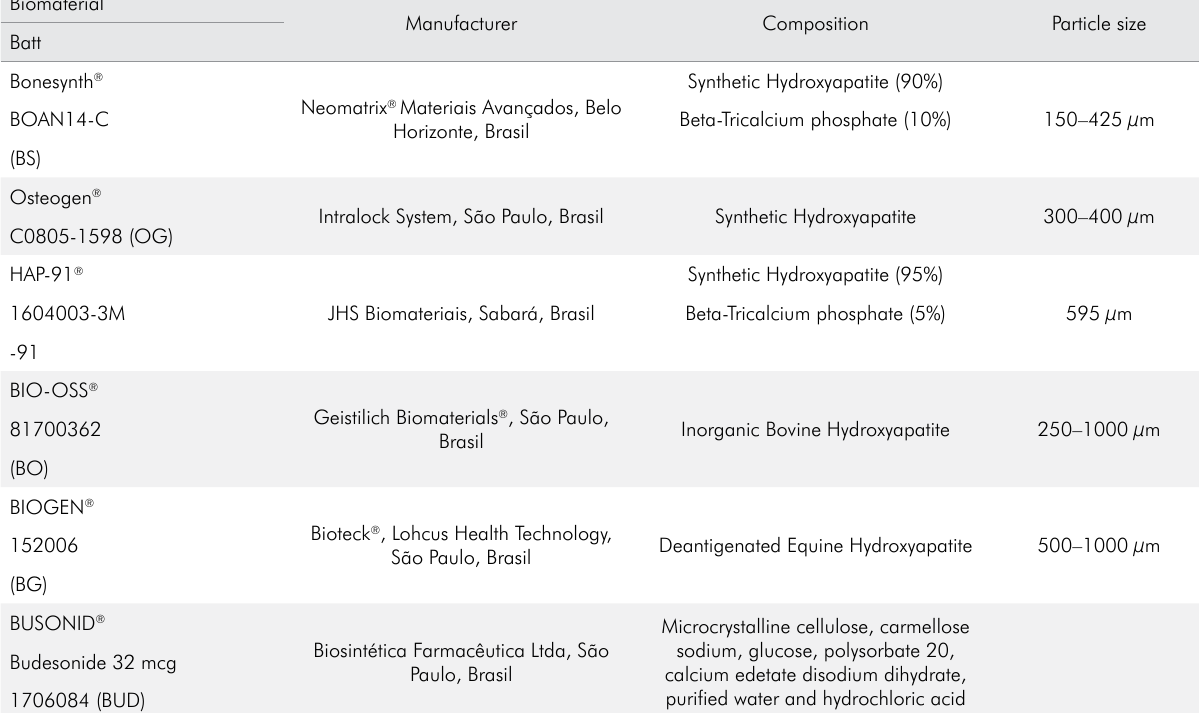
Table 1. Description and composition of the biomaterials and drug used in the study.